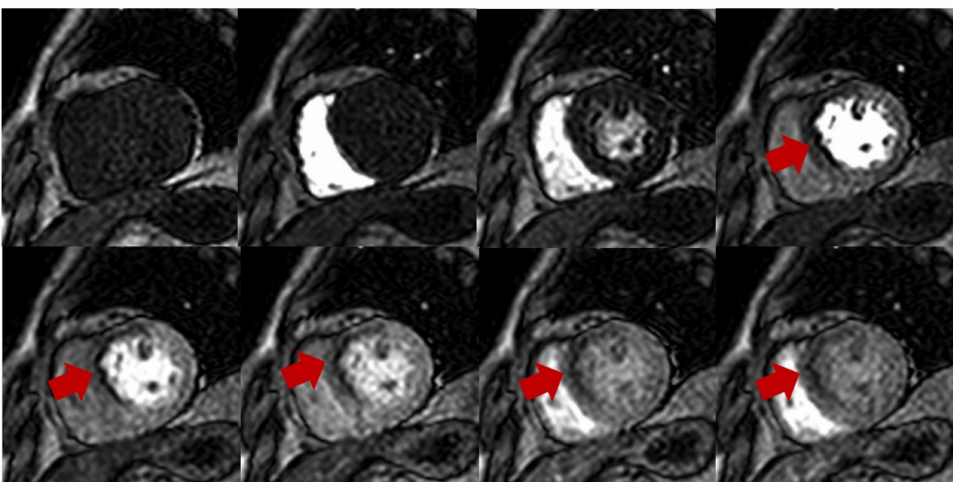
Figure 1. Stress perfusion showing myocardial ischemia using adenosine. Upper and lower panel shows a single basal ventricular short axis slice acquired during stress perfusion imaging. The gadolinium contrast first enters the right ventricle, then the left ventricle, and finally perfuses the myocardium. Red arrow shows myocardial ischemia in the basal anteroseptal wall with decreased T1 signal compared with normal